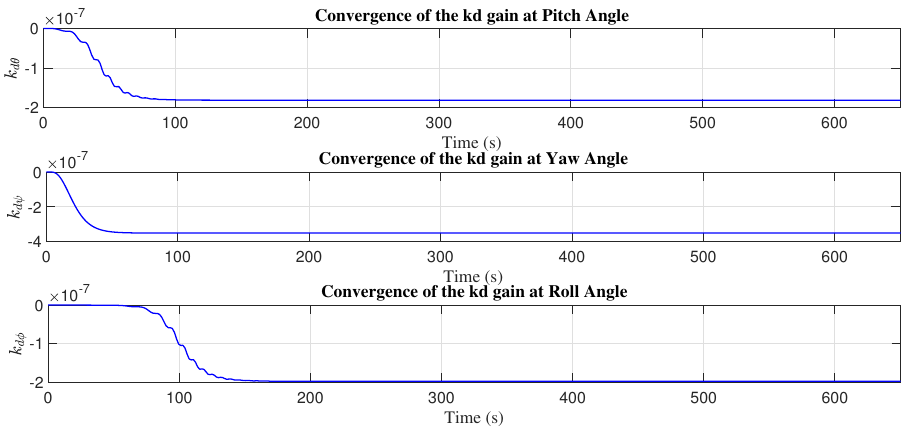
Figure 14. Convergence ˆ k d response with MIT rule.